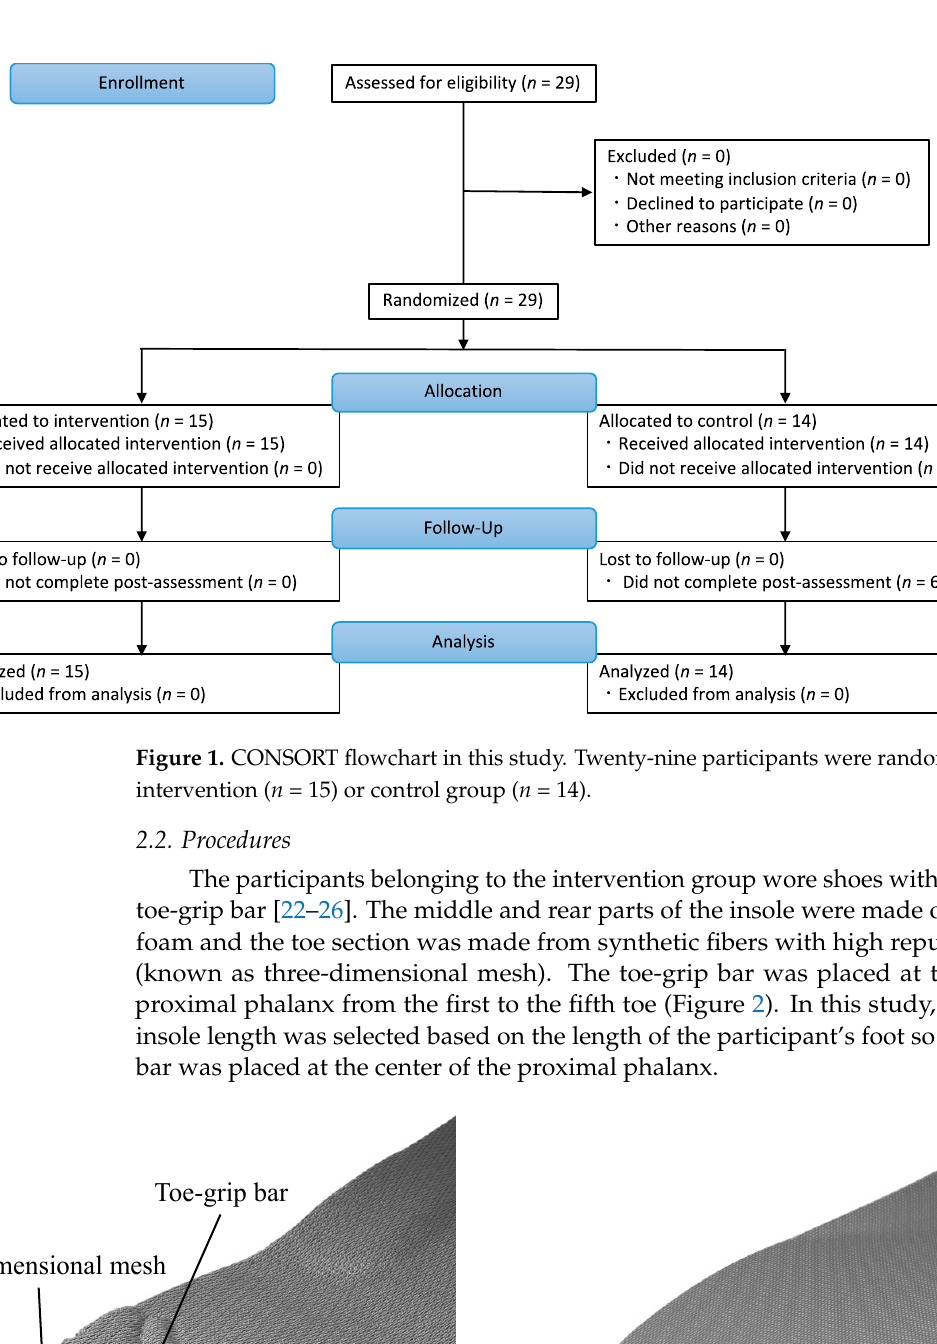
Figure 1. CONSORT flowchart in this study. Twenty-nine participants were randomly assigned to an intervention ( n = 15) or control group ( n = 14).